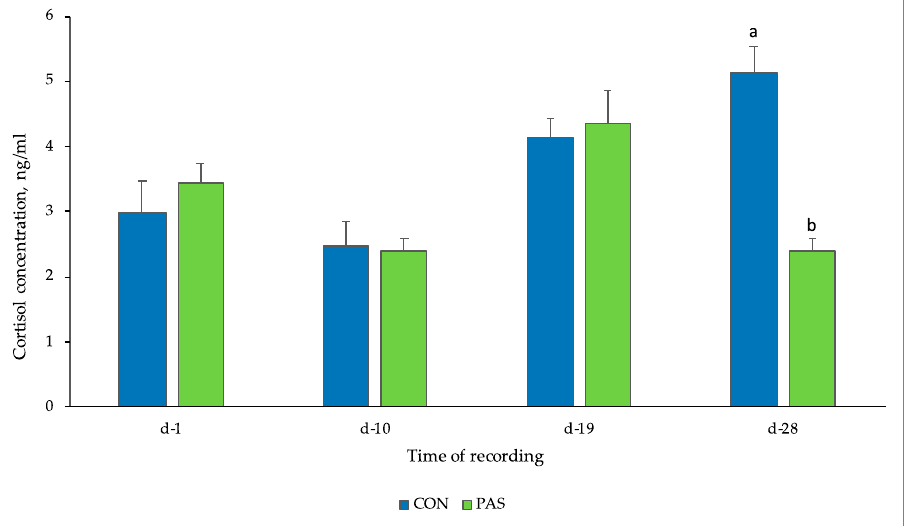
Figure 2. Cortisol concentrations (mean ± SE) found in saliva samples of two experimental groups.